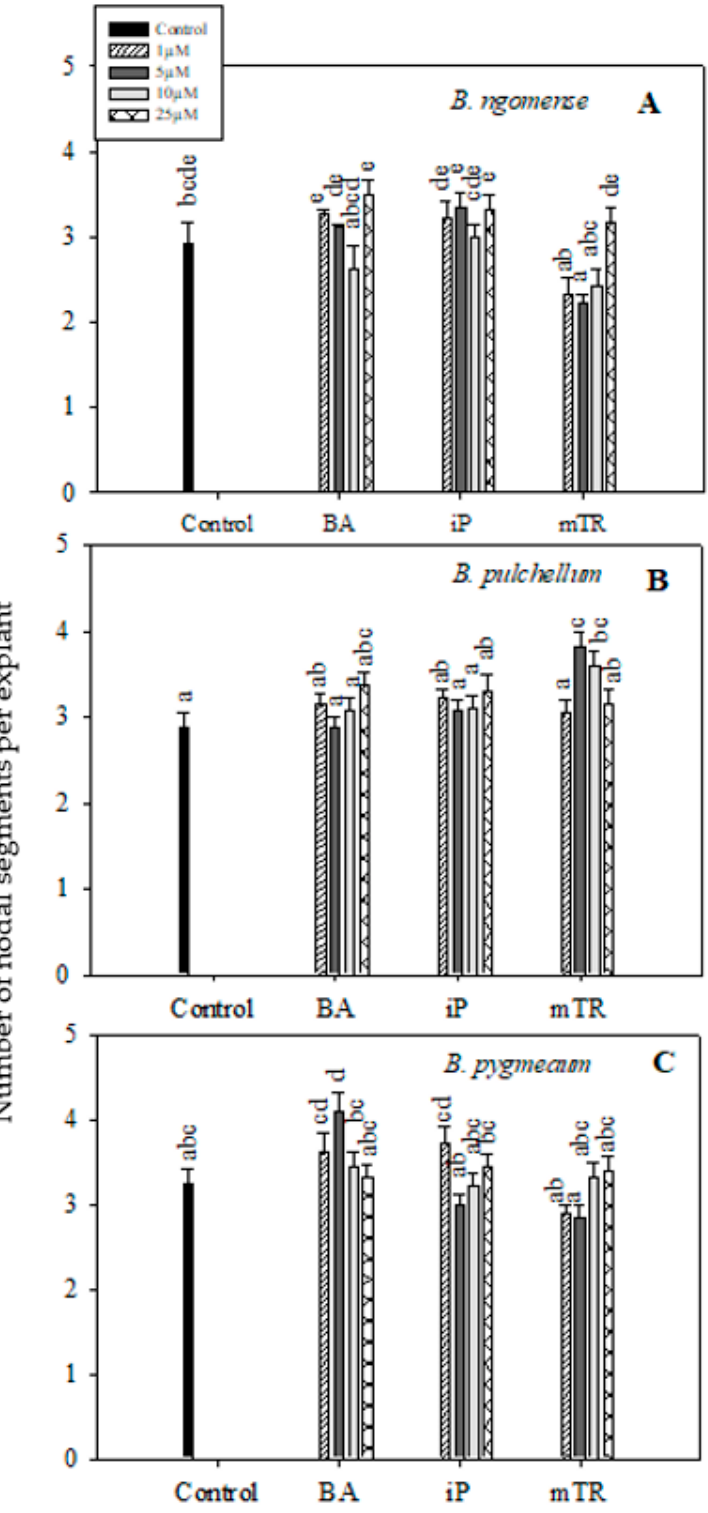
Figure 3. Effect of varying concentrations of cytokinins on the number of nodal segments in ( A ) Brachystelma ngomense , ( B ) Brachystelma pulchellum and ( C ) Brachystelma pygmaeum after six weeks in culture. In each graph, different letter(s) on the bars show significant differences according to Duncan’s multiple range test (DMRT) ( p ≤ 0.05). N 6 -benzyladenine (BA), isopentenyladenine (iP) and meta -topolin riboside ( m TR).